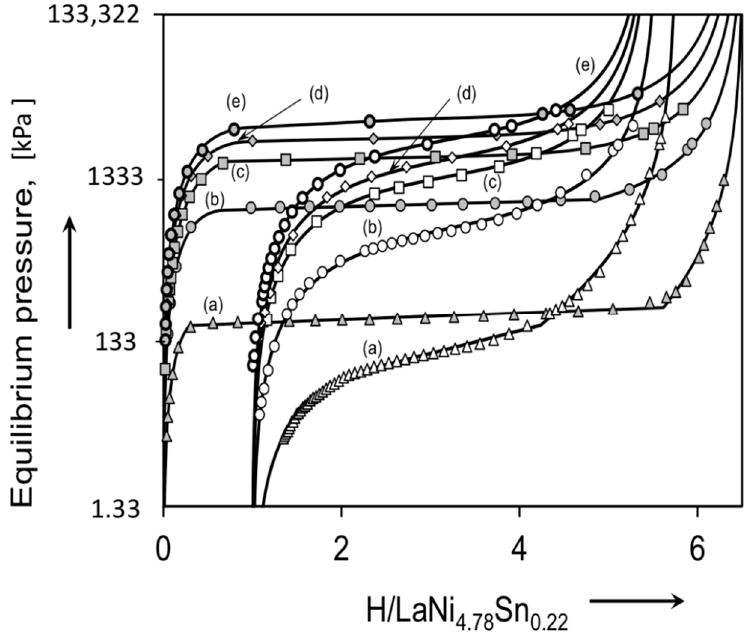
Figure 8. Comparison of desorption isotherms for LaNi 4.78 Sn 0.22 H x at various temperatures before (filled symbols) and after (open symbols) aging a hydride sample with x ~5.0 at 500 K for 1207 h is shown. Experimental results are the data points: ( a ) 292 K ( Δ ), ( b ) 374 K (o), ( c ) 425 K ( □ ), ( d ) 450 K ( ◊ ), and ( e ) 476 K (bold “o”). The lines are the simulation results generated via the model described in Reference [35] (2019, with permission from Elsevier).